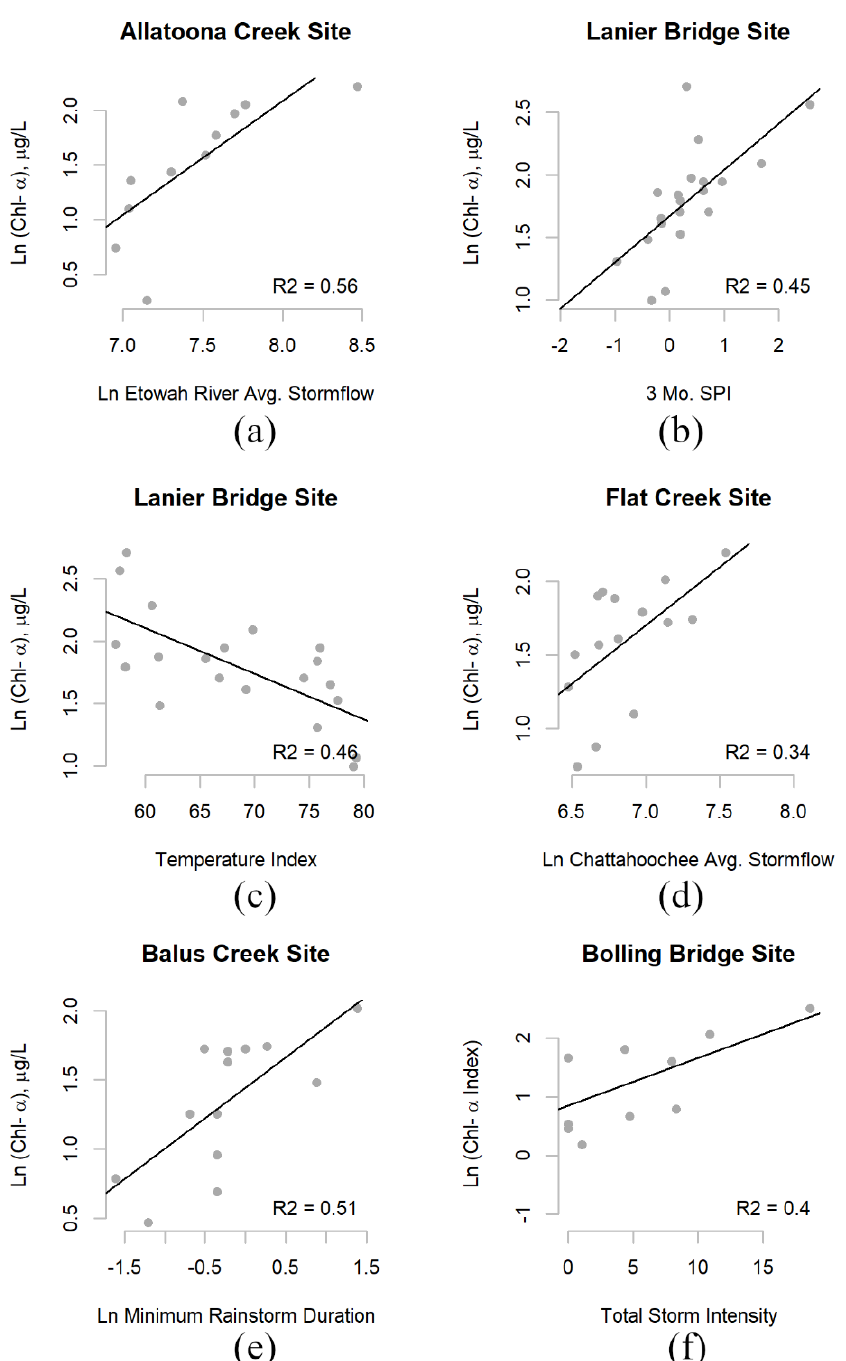
Figure A2. Bivariate plots showing the spread and slope of several of the high-performance chl-a models. ( a ) Chlorophyll-a as a function of Etowah River average stormflow; ( b ) Chlorophyll-a as a function of the three-month Standard Precipitation Index at Lake Lanier; ( c ) Chlorophyll-a as a function of the NOAA Temperature Index at Lake Lanier; ( d ) Chlorophyll-a as a function of Chattahoochee River average stormflow; ( e ) Chlorophyll-a as a function of the monthly minimum rainstorm duration at Lake Lanier; ( f ) Chlorophyll-a as a function of total storm intensity at Lake Lanier.